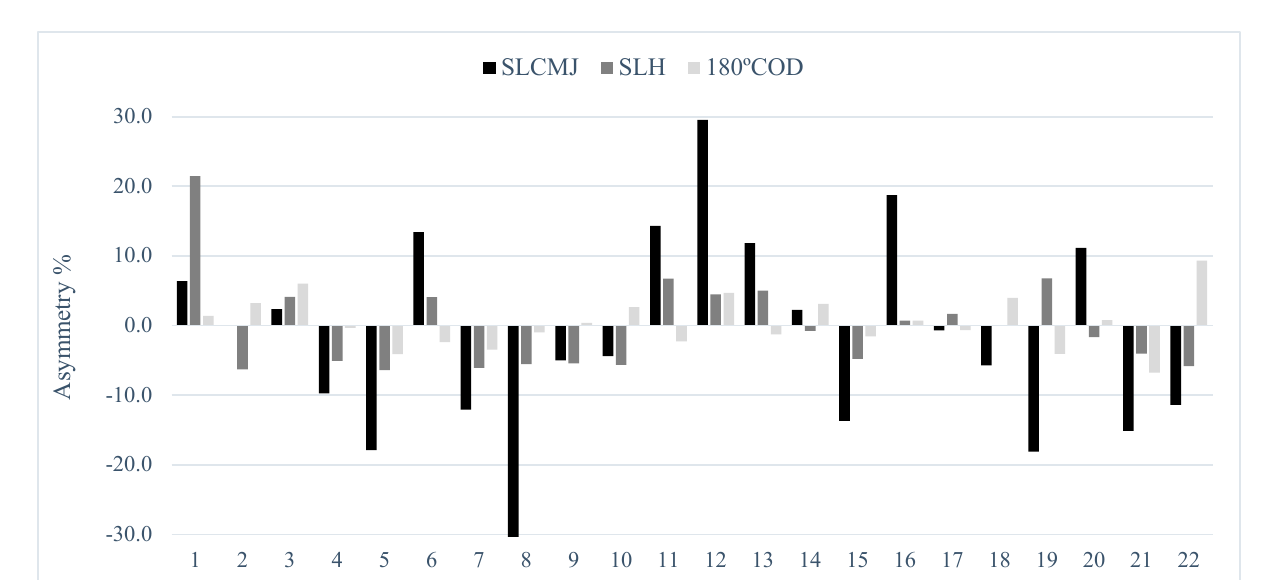
Figure 2. Data about individual asymmetry for single leg countermovement jump (SLCMJ), single leg hop (SLH) and 180° change of direction (180° COD) in the U-16 group. N.B: above 0 indicates right leg dominance and below 0 indicates left leg dominance.